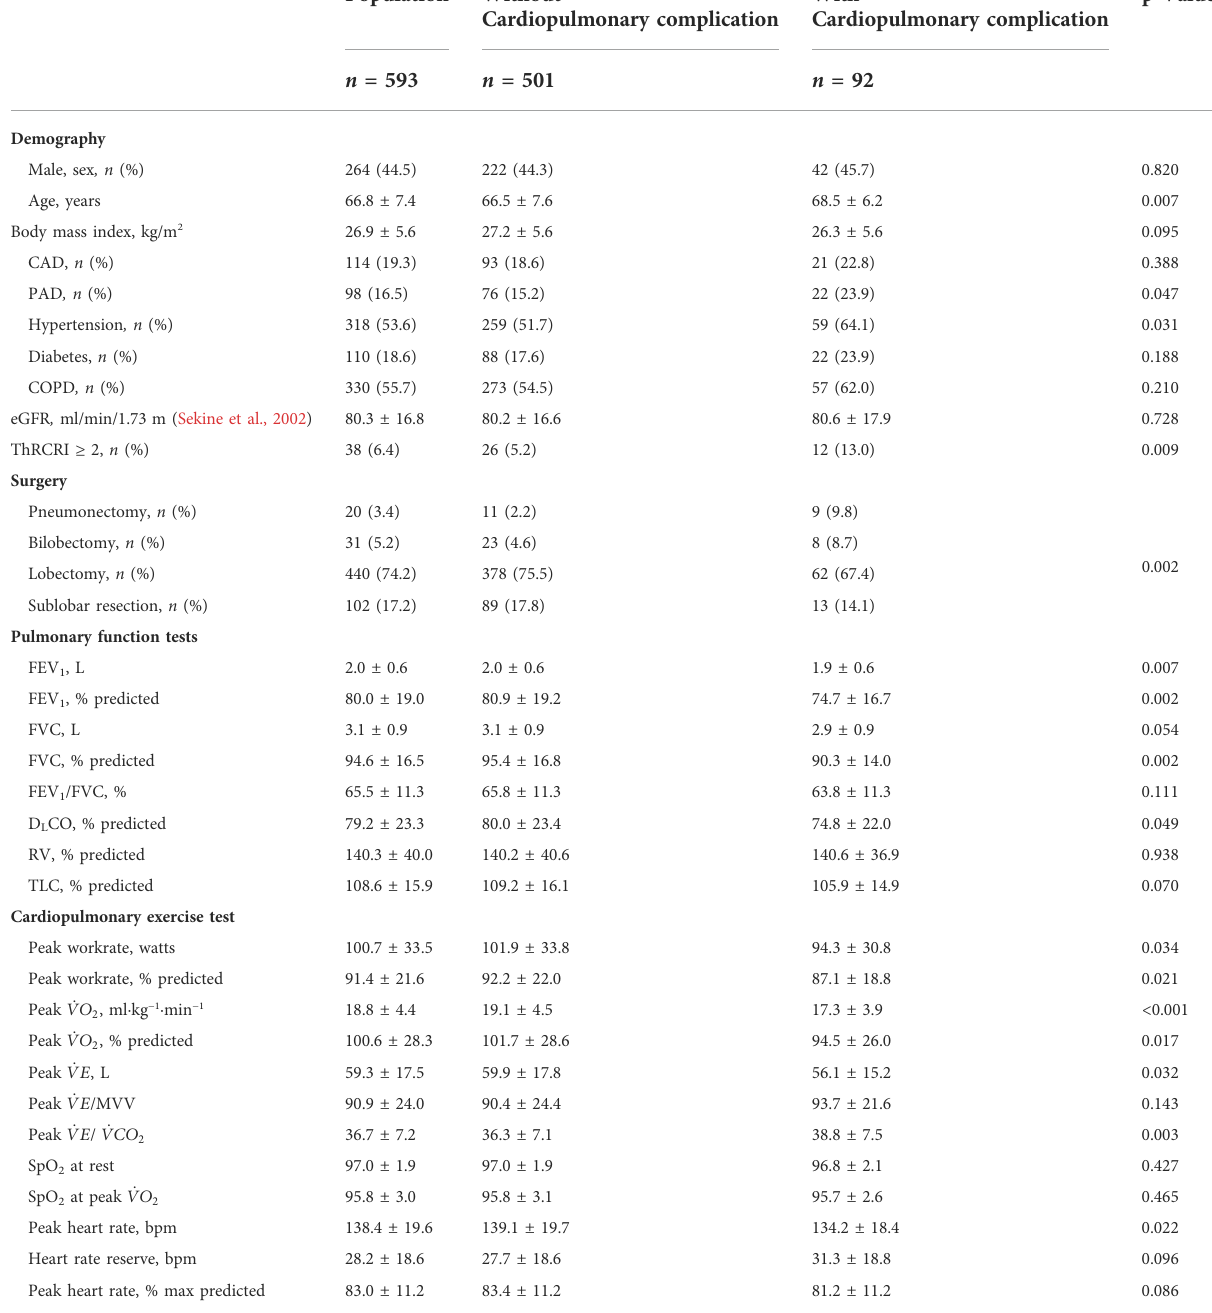
Population Without Cardiopulmonary complication